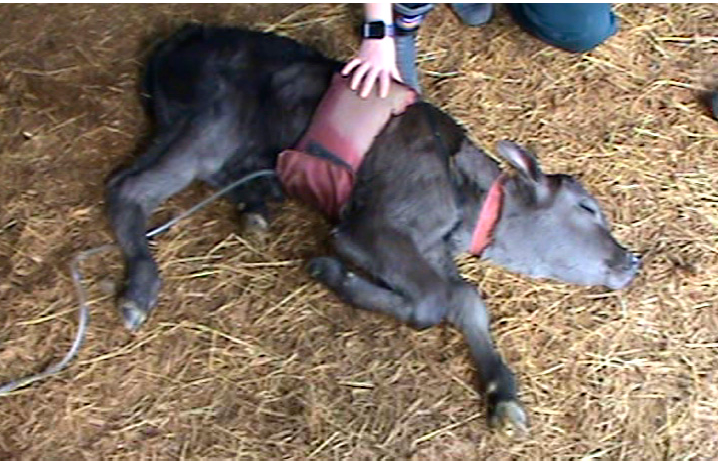
Figure 2. Novel inflation cuff applied to a calf, secured around the thorax with Velcro and fastened to a soft fabric black strap around the neck to prevent slippage onto the abdomen.